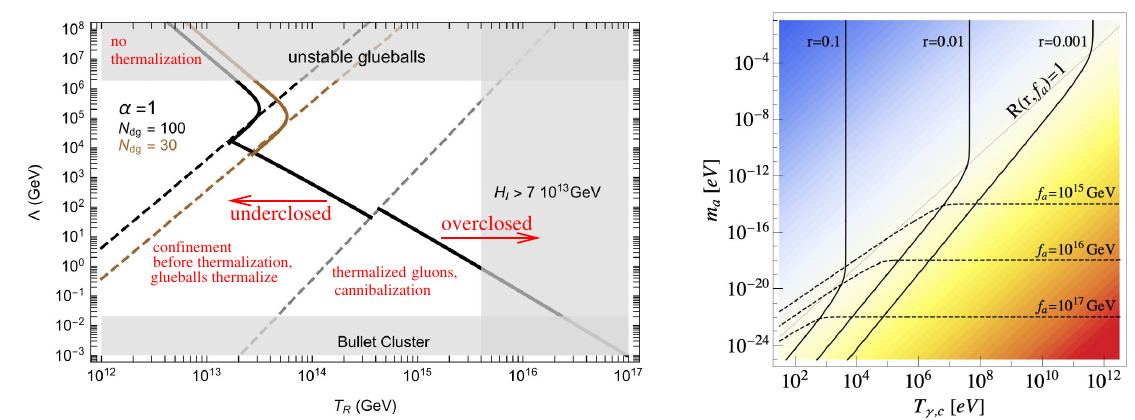
Figure 11: Left: parameter space for gravitational production of dark glueballs, adapted from Ref. [ 84 ] . “Unstable glueballs” refers to gravitational decays (which are unavoidable in any model of dark glueballs) faster than the present Hubble rate. α refers to the 3 → 2 cross section 〈 σ v 2 〉 ≡ α 3 / m 3 . N is the assumed number DG 3 → 2 0 of glueballs produced per gluon in the phase transition with unthermalized gluons. Right: regions of glueball- (blue) versus axion-dominated (red) DM in the plane of axion mass versus photon temperature at the time of the confinement phase transi- tion, from Ref. [ 85 ] . Here r = ξ and ξ , f are adjusted to give observed DM abun- a dance at each point in the